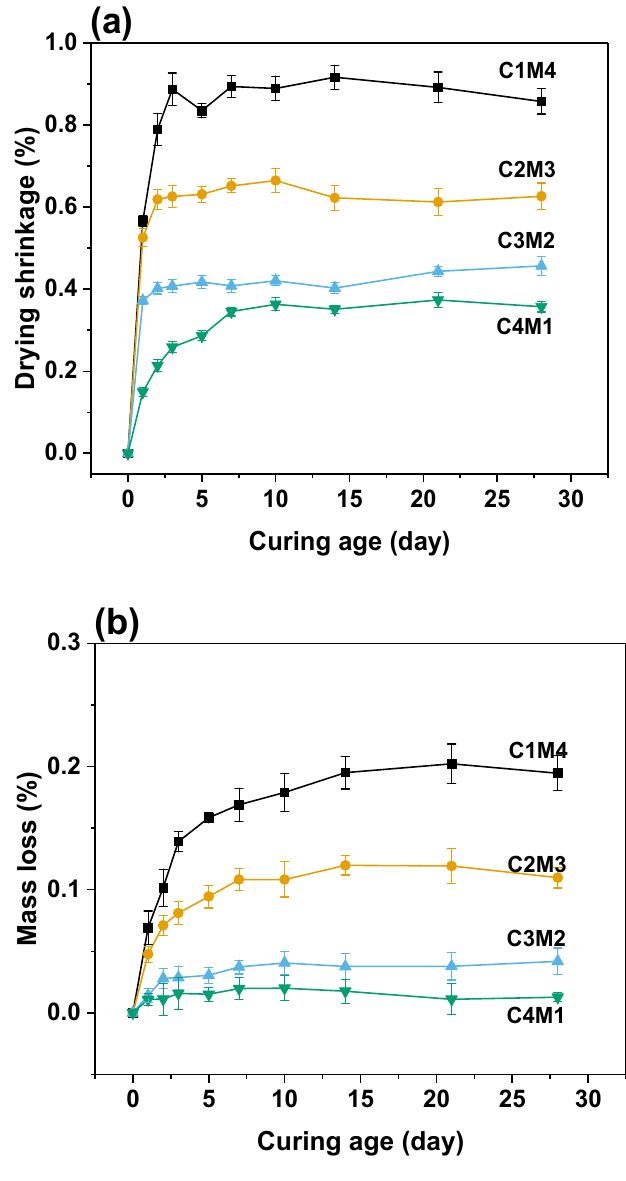
Figure 6. ( a ) Drying shrinkage and ( b ) mass loss of the Na 2 CO 3 -activated slag binders exposed to 60% relative humidity environment.